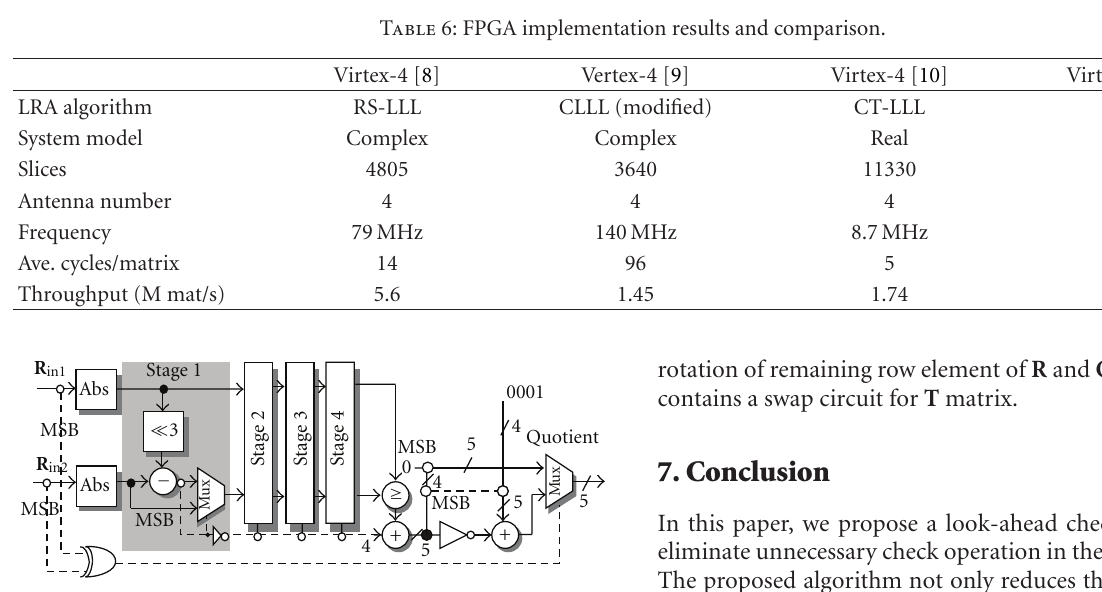
Figure 5: Division and round